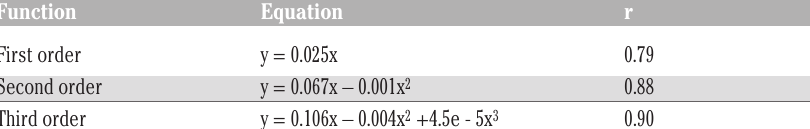
Table 1. The y (PI) to x (gestational age)